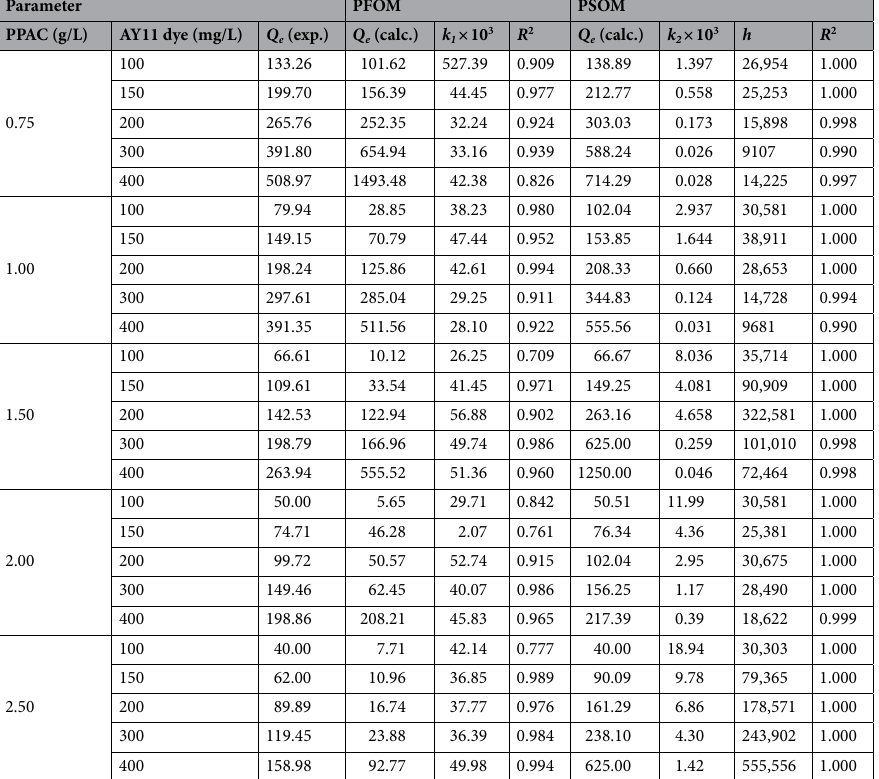
Table 4. PFOM and PSOM results of AY11 dye adsorption by PPAC adsorbent [ C 0 (100–400 mg/L), PPAC (0.75–2.50 g/L), Temp. (25 °C)].